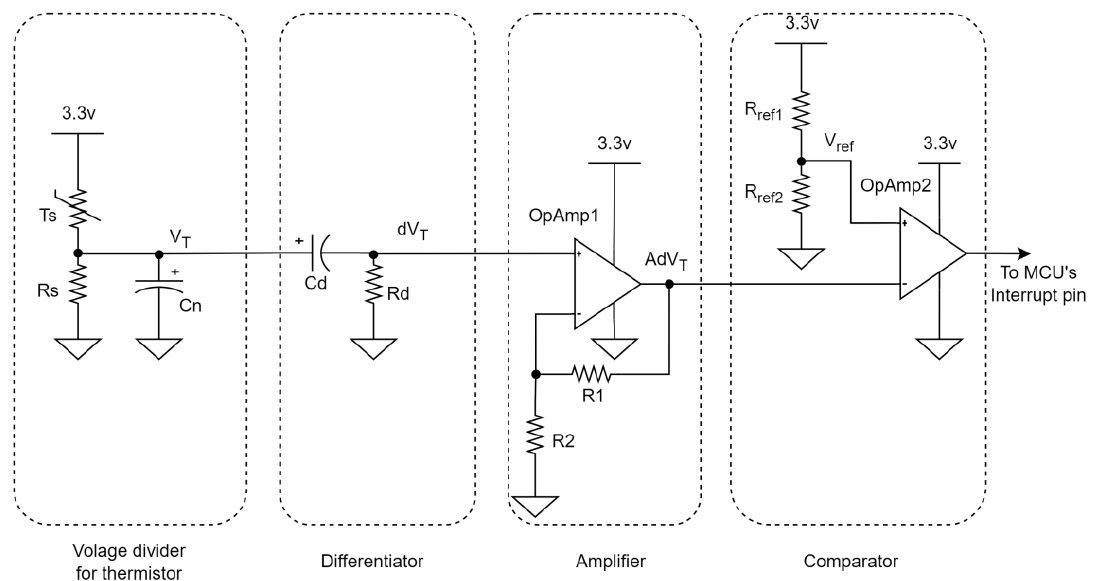
Figure 4. The sudden rise in temperature hardware detector.